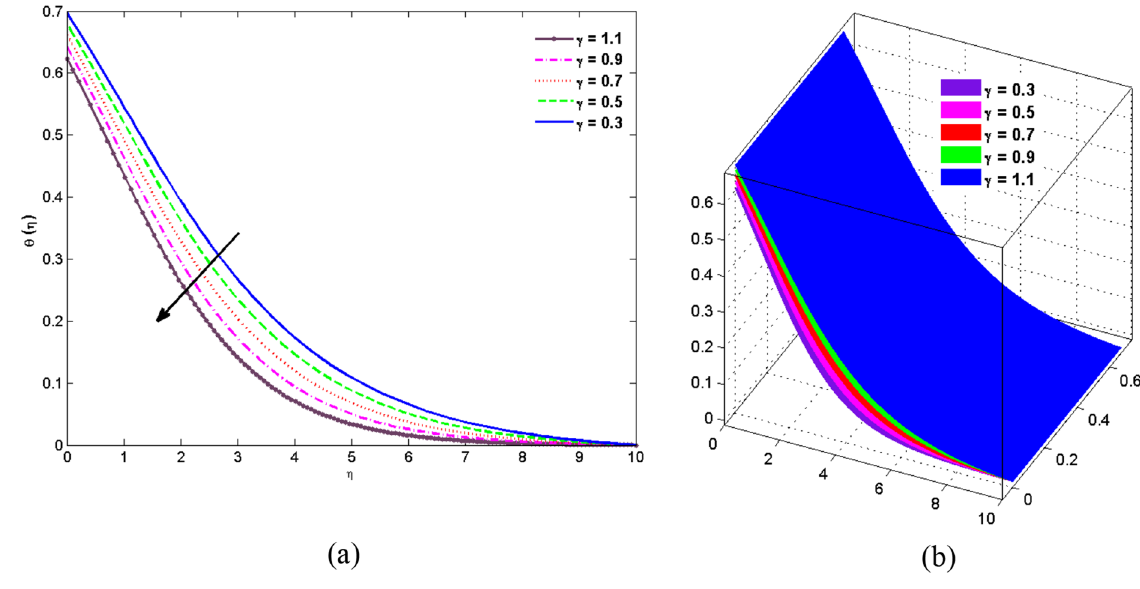
Figure 9. Variations of γ to θ(η) .